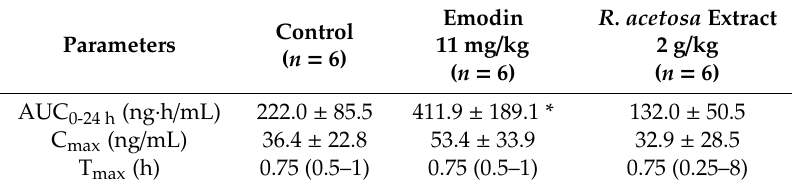
AUC 0-24h , total area under the plasma concentration–time curve from time zero to 24 h; C max —maximum plasma concentration; T max —time to reach C max ; *— p < 0.05 compared to vehicle only control